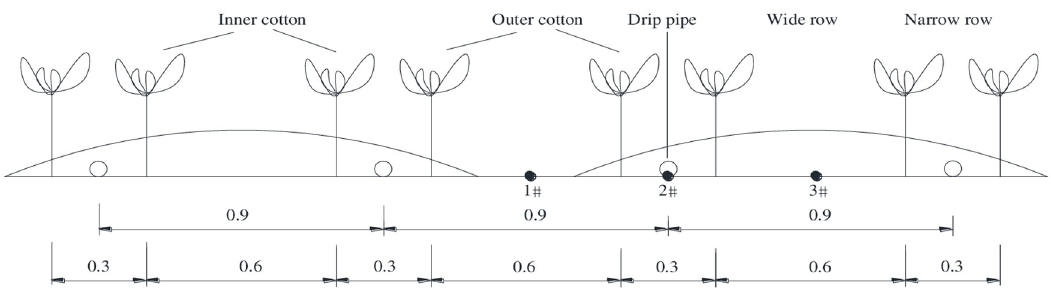
Fig 1. Field scheme of four cotton rows with one dripping pipe under mulch mulching and soil water content sampling point